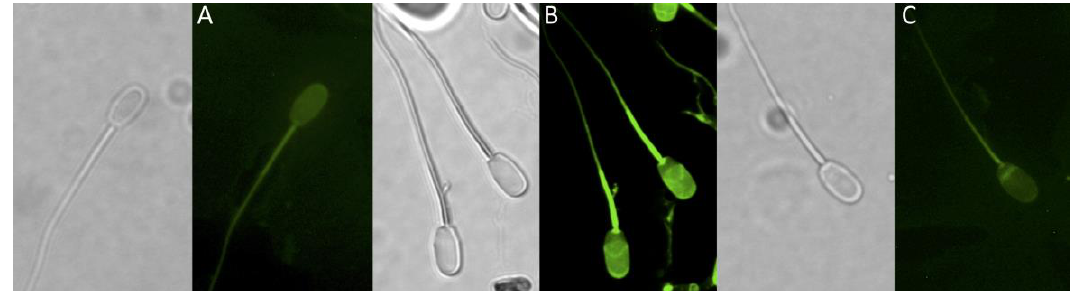
Figure 2. CTC stain patterns. 3 different patters were observed with the use of CTC stain. ( A ) Non-Capacitated, fluorescence throughout the spermatozoa head. ( B ) Capacitated, intense fluorescence in the equatorial and acrosomal zone. ( C ) Acrosomal reacted, fluorescence in equatorial and sometimes in the post-equatorial zone.